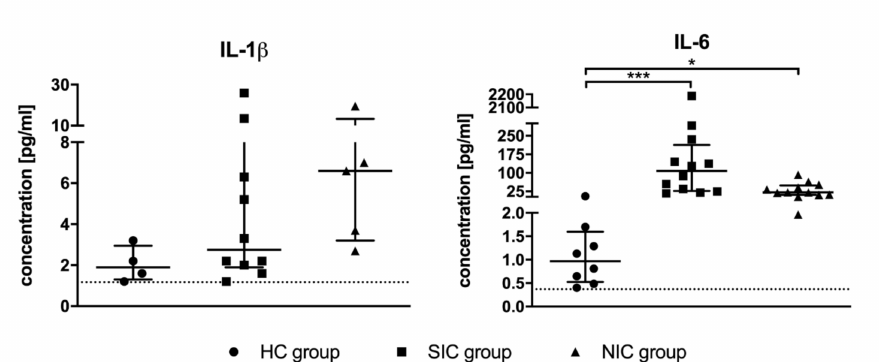
Figure 2. Serum concentrations of the pro-inflammatory cytokines interleukin 1 β (IL-1 β ) and interleukin 6 (IL-6) were determined by means of suitable ELISA kits. The blood sample was taken immediately after admission to the intensive care unit (ICU). Data are presented as median ± IQR; the asterisk denotes a significant group di ff erence (* p < 0.05, *** p <